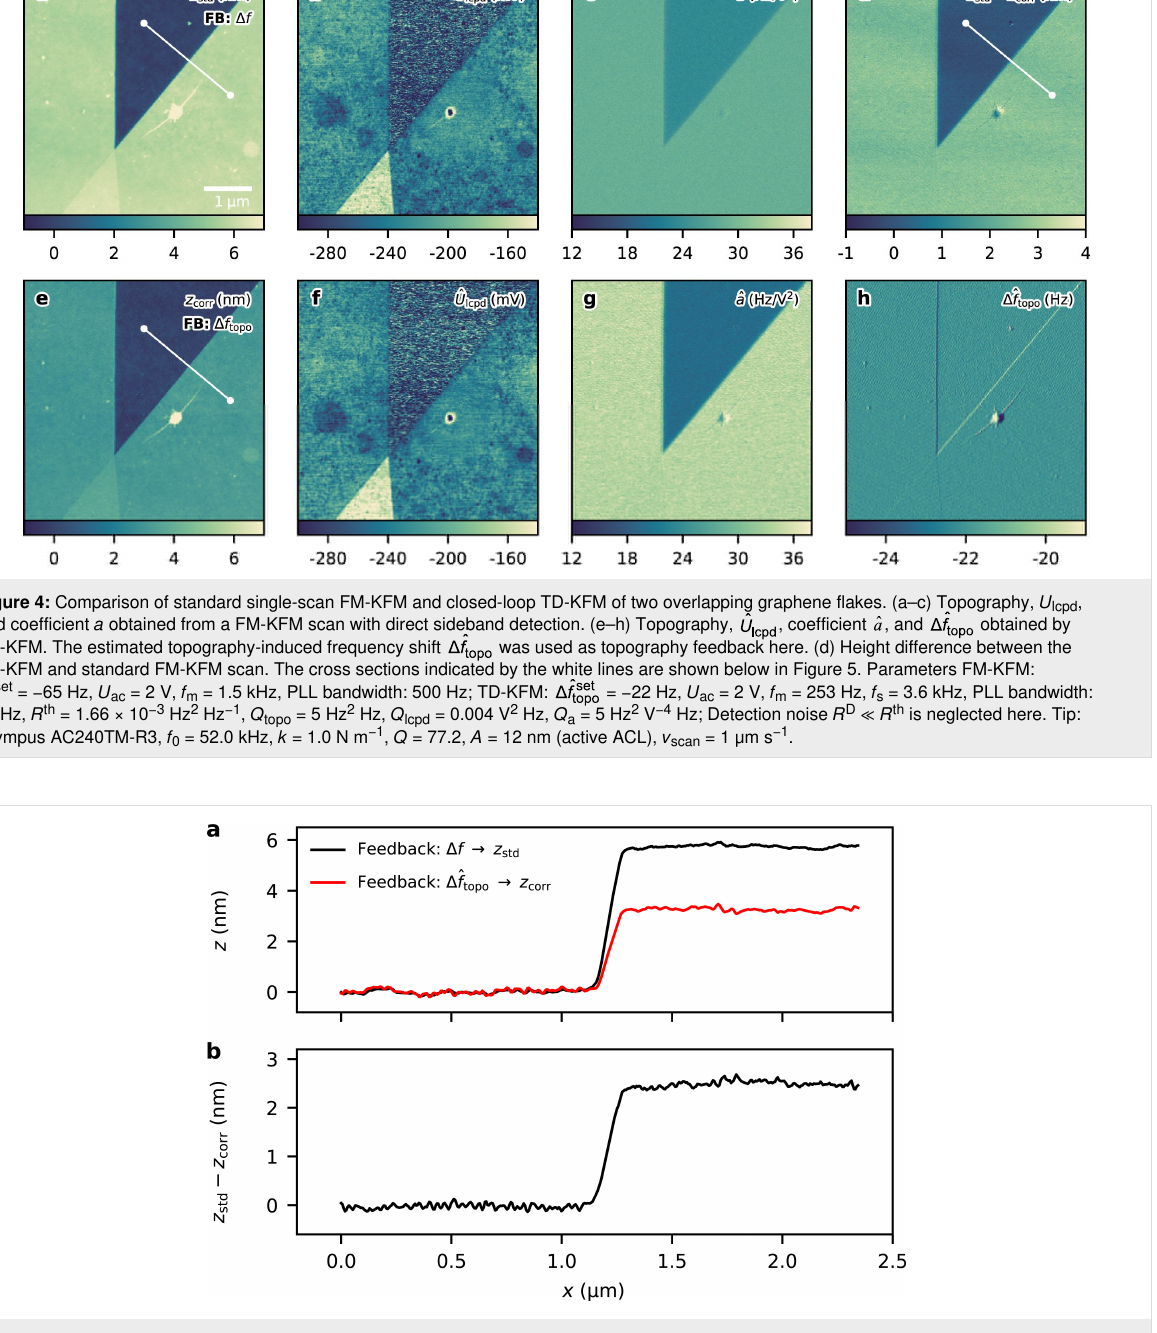
Figure 5: (a) Cross sections of the topography along the sections indicated in Figure 4 for single-scan FM-KFM (feedback on Δ f ) and closed-loop TD-KFM (feedback on ). (b) Difference between both topography measurements. Closed-loop TD-KFM minimizes the electrostatic height error beyond what is achievable in standard